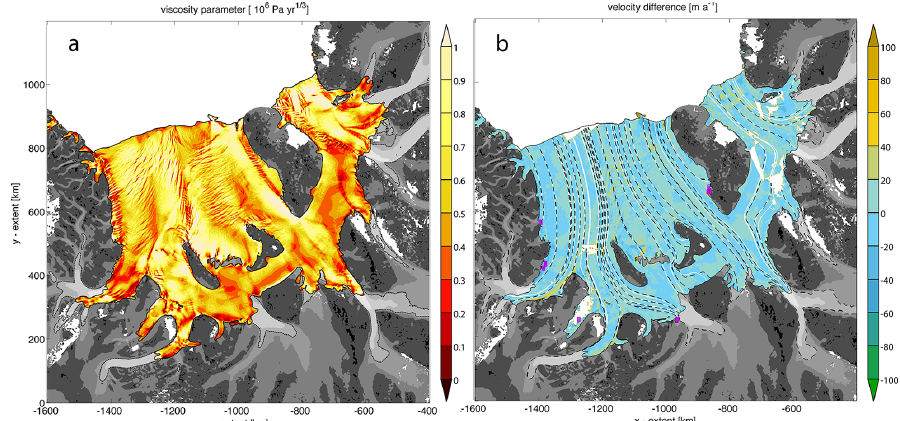
Figure 4. Ice viscosity parameter (a) and the difference between simulated and observed ice velocity magnitudes (b) on Filchner–Ronne Ice Shelf (as in Fig. 1). Shading and contour lines as in Fig. 3. Results are based on the T geometry without complementary information on pinning points. White areas indicate regions without velocity